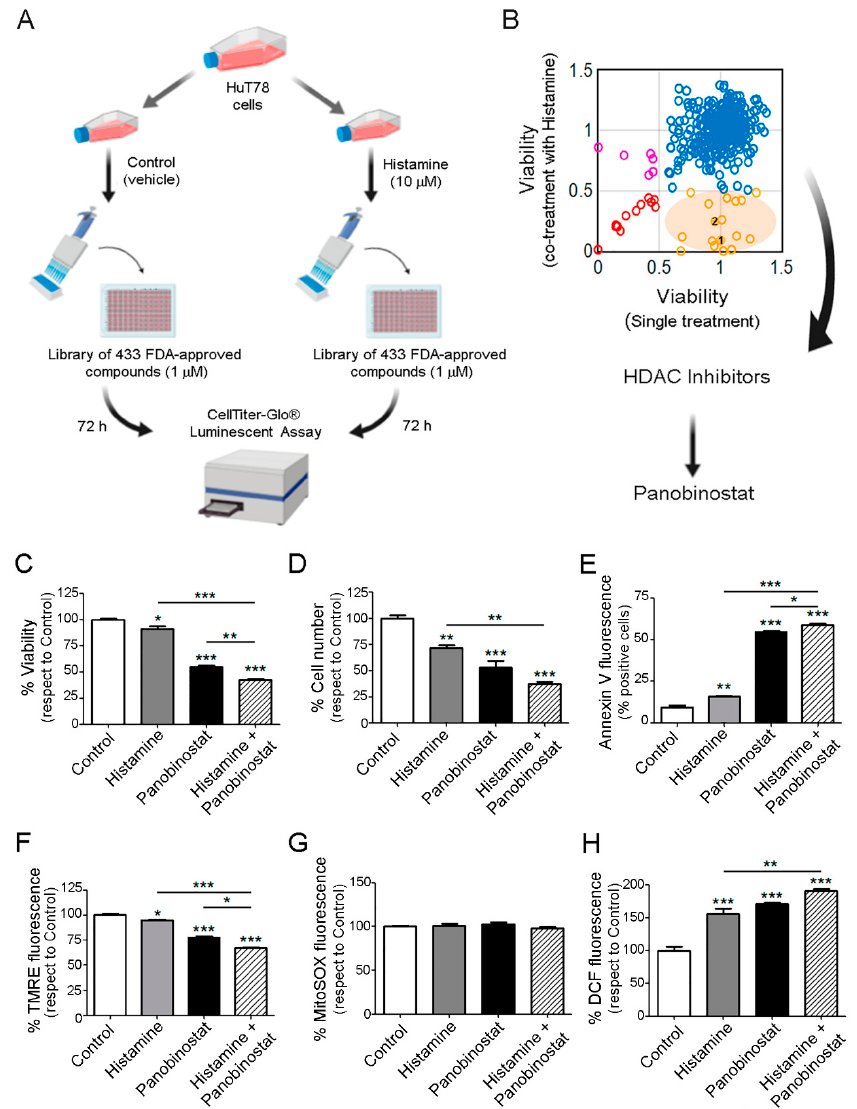
Figure 5. Screening of a library of 433 FDA-approved compounds. Effect of the combination of histamine and panobinostat on HuT78 cell proliferation, apoptosis, and ROS production. HuT78 cells were pre-incubated for 24 h in serum-free RPMI medium and then were treated with the FDA-approved drug (single treatment) or were treated with the combination of histamine (10 µ M) plus FDA-approved compound for 72 h in triplicates for each condition. ( A ) Experimental design. ( B ) Results of the screening experiment, showing potential favorable effects with the combined treatment of histamine plus HDAC inhibitors: (1) panobinostat, (2) belinostat. ( C ) HuT78 cells were pre-incubated for 24 h in serum-free RPMI medium and then were left untreated (control) or were treated with histamine (10 µ M) and/or panobinostat (1 µ M) for 48 h in complete medium, as indicated. Cell viability was evaluated by Cell Titer Blue Assay. ( D ) The cell number was counted using a Neubauer chamber. ( E ) Percentage of Annexin-V positive cells. ( F ) Mitochondrial membrane potential measured by the TMRE fluorescence determination. ( G ) MitoSOX fluorescence (5 µ M) was measured using a microplate reader. ( H ) DCF fluorescence (10 µ M DCFH-DA) was measured using a microplate reader. Measurements were performed in quintuplicate ( C ) and triplicates ( D – H ) for each condition and cell line and data are expressed as mean ± SEM ( n = 3 independent experiments). * indicates p < 0.05, ** indicates p < 0.01, *** indicates p < 0.001 compared with